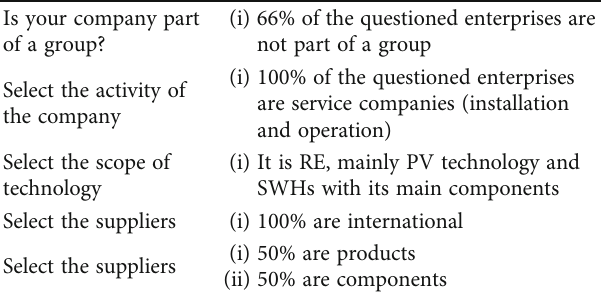
Table 8: Introductory information about domestic enterprises working in the fi eld of RE and